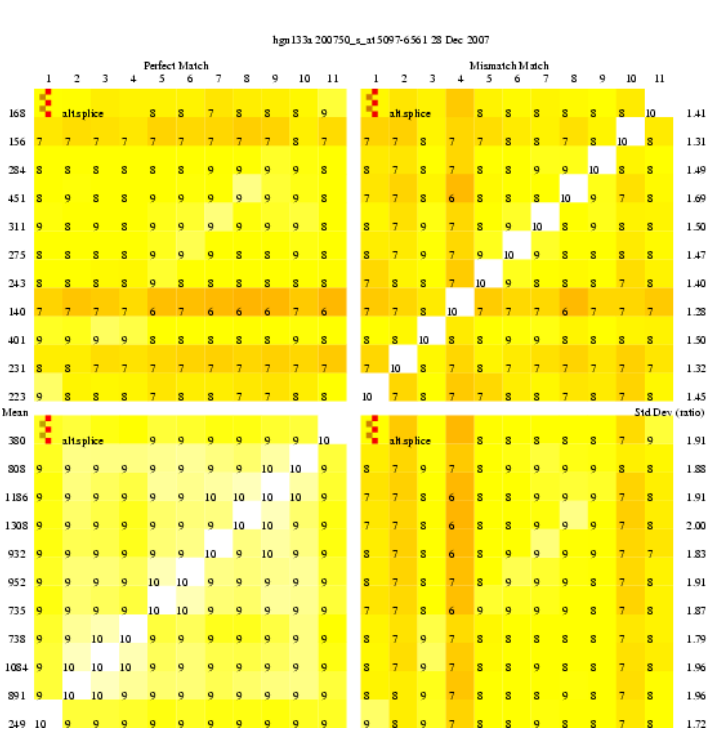
Figure 8: The correlations in intensities (log2) between probes in probeset 200750 s at on HG- U133A. There is considerable correlation between all the probes, including mismatch probes. This suggests that in this probeset mismatch probes contain information about the expression of the transcript, rather than as a measure of the background signal.